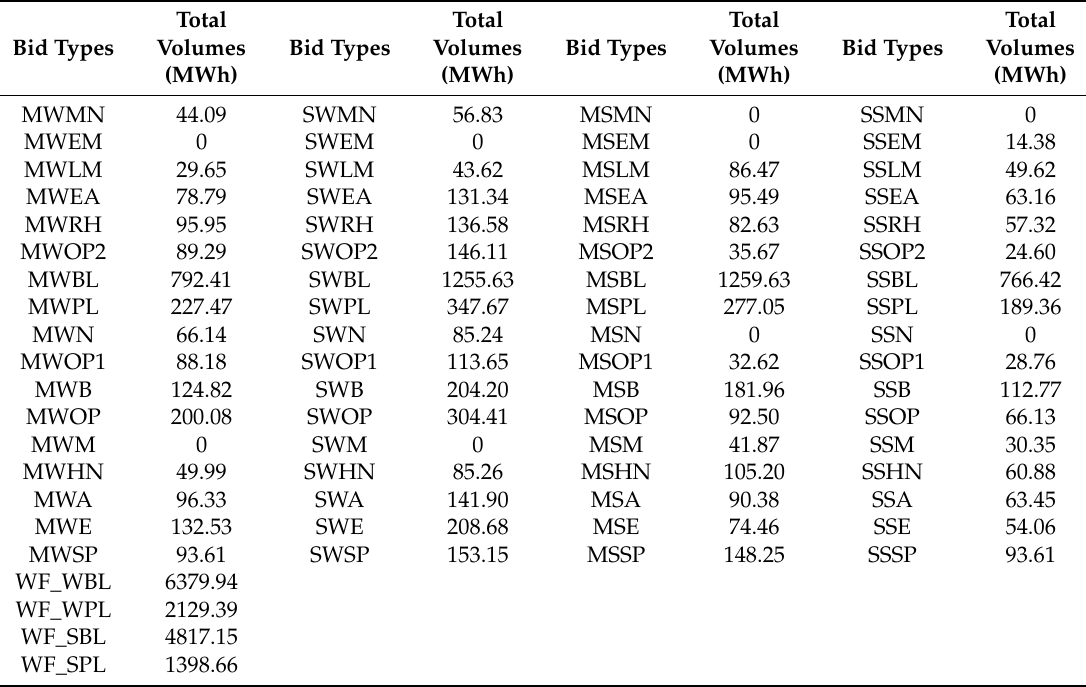
Table A4. Total volume each bid types.